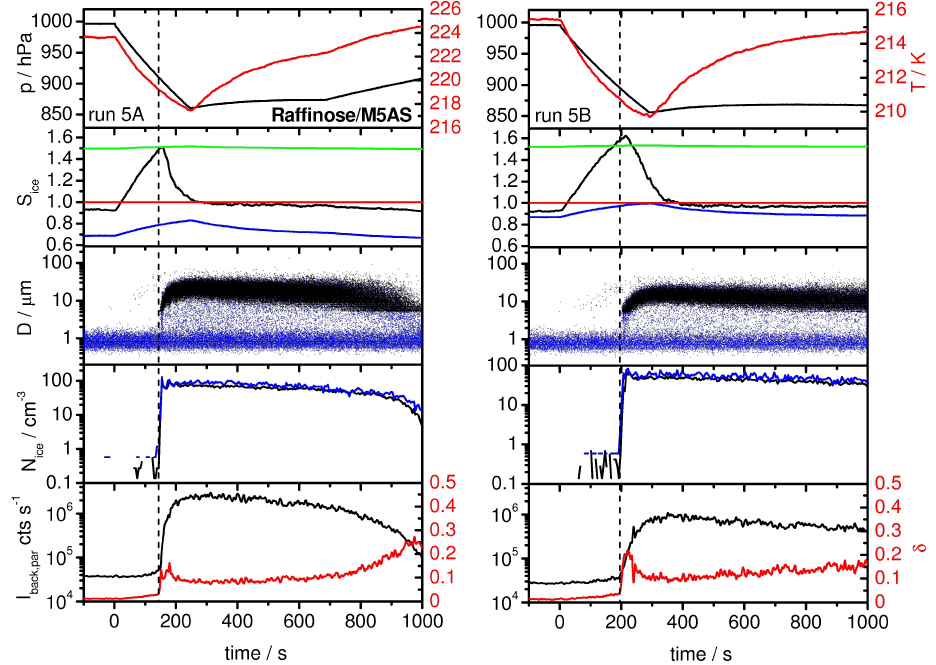
Fig. 13. Time series of various AIDA records during expansion runs 5A and 5B with raffinose/M5AS aerosol particles. The individual panels contain the same measurements as in Fig.